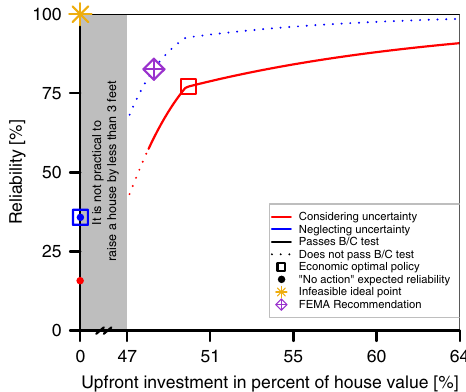
Fig. 4 Impact of uncertainty on the trade-off. Trade-offs between the upfront cost and reliability with and without considering uncertainties. The trade-off considering-uncertainty and ignoring-uncertainty are shown in red and blue, respectively. Along each line, the dashed parts indicate that the policy does not pass the cost-bene fi t test (i.e., the bene fi t-to-cost ratio is less than one). Heightening policies of 0 – 3 ft are blocked by the gray area as we assume that it is impractical to elevate a house by less than three feet. The “ not elevating ” policies are shown by dots and the optimal elevations are shown by squares. The infeasible ideal point (zero cost and 100% reliability) is shown by a star.